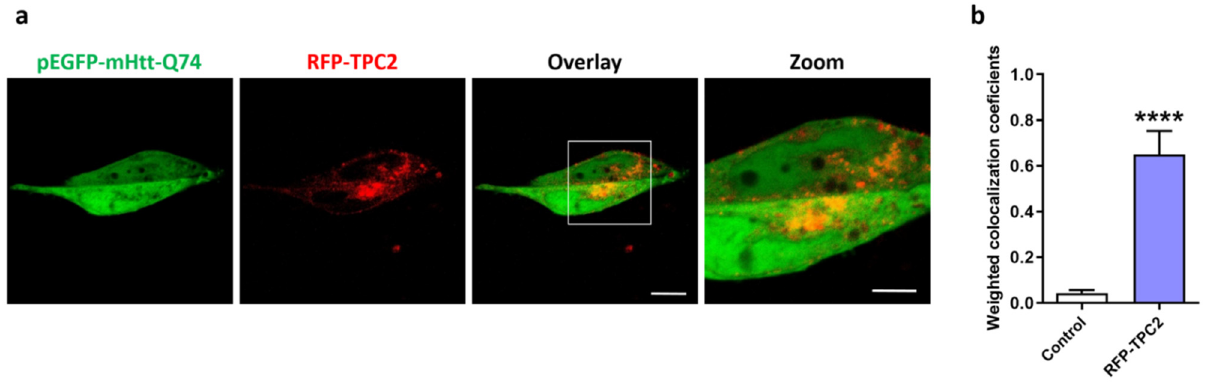
Figure 2. Evaluation of colocalization between the TPC2 receptor and mHtt-Q74. Astrocytes were transfected with pEGFP-mHtt-Q74 and RFP-TPC2 vectors, followed by evaluation of the cells in a confocal microscope. ( a ) Representative images of astrocytes overexpressing mHtt-Q74 protein (pEGFP-mHtt-Q74, green fluorescence) and TPC2 (RFP-TPC2, red fluorescence). The merged images show both fluorescence signals, and digital zoom (2×) on specific areas of interest was applied to demonstrate colocalization between the fluorescence signals. Images were obtained using a Carl Zeiss LSM 780 confocal microscope, with 63× magnification. Scale bar: 10 µm and 5 µm. ( b ) Quantification of colocalization between pEGFP-mHtt-Q74 (green fluorescence) and RFP-TPC2 (red fluorescence), calculated according to the weighted colocalization coefficient. n = 3. Data presented as mean ± SEM. Unpaired Student’s t test, **** p < 0.0001.